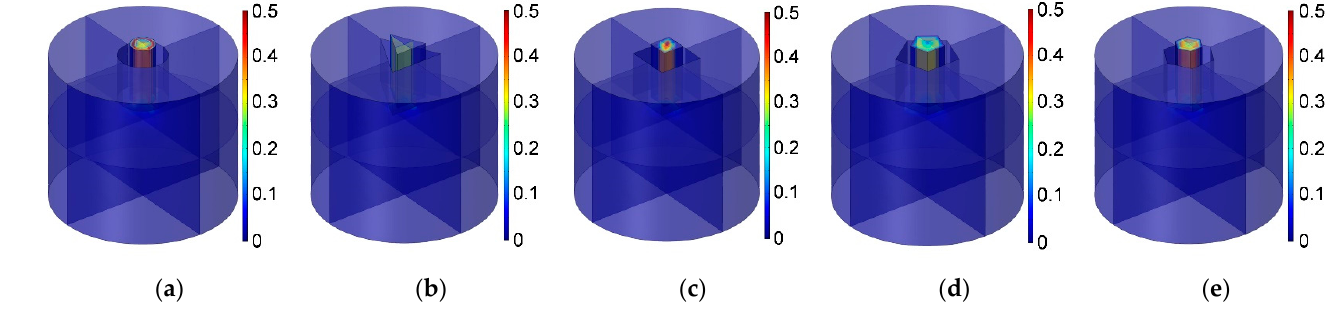
Figure 24. Distribution of acoustic velocity for the HR with the aperture for various cross-sectional shapes. ( a ) Round; ( b ) regular triangle; ( c ) square; ( d ) regular pentagon; and ( e ) regular hexagon.